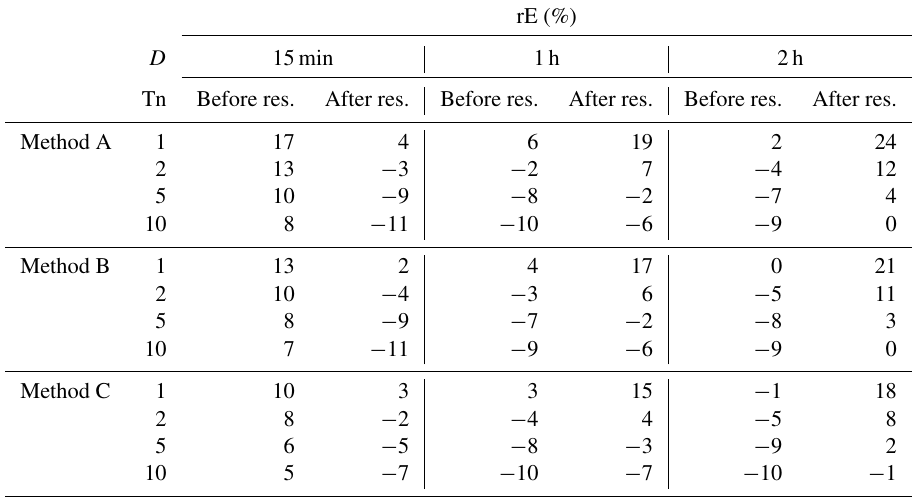
Table 5. The median of rE of extreme rainfall events (over all stations and realisations) for different return periods and disaggregation methods before and after the resampling. rE (%) D 15min 1h 2h Tn Before res. After res. Before res. After res. Before